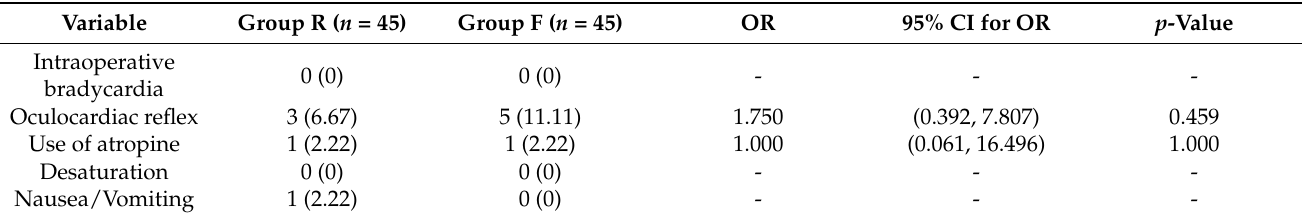
Table 6. Perioperative adverse